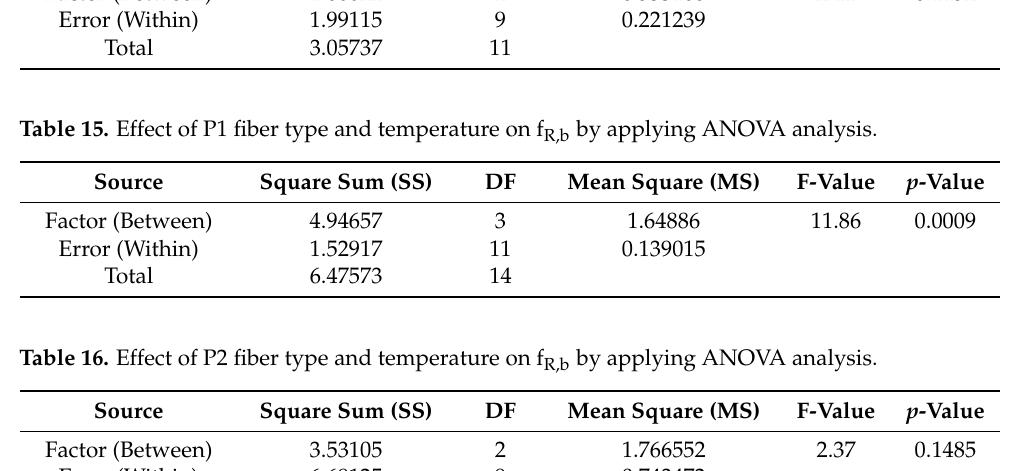
Table 14. Effect of S fiber type and temperature on f R,a by applying ANOVA analysis. Source Factor (Between)